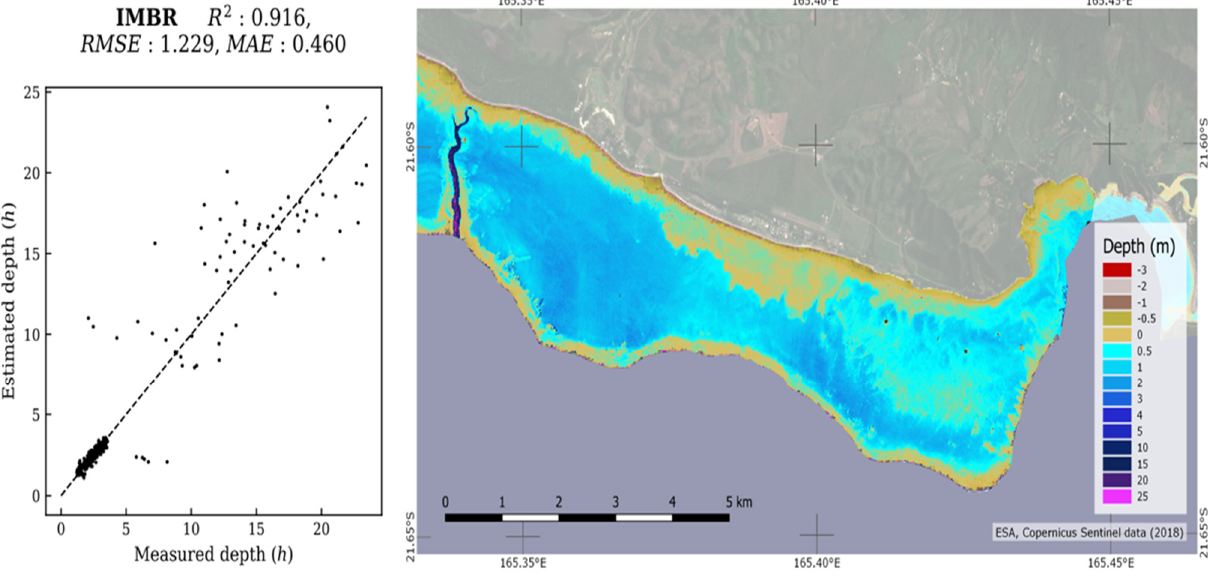
Figure 7. IMBR-derived bathymetry for the ELA (calibration on the global dataset). Predictions are at zero hydrographic level; therefore, the very few red pixels on prediction maps are incoherent prediction, estimated above sea level. Accuracy metrics are provided above the validation plot.